Question: What type of chart is this?
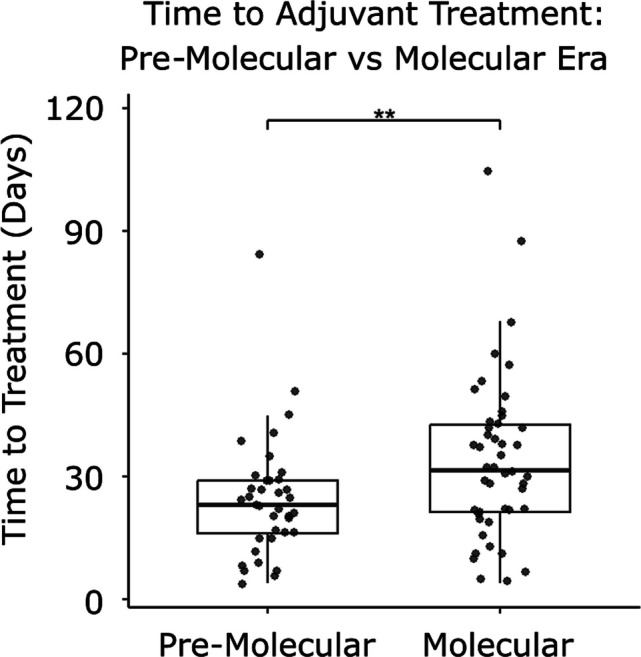
Answer: box